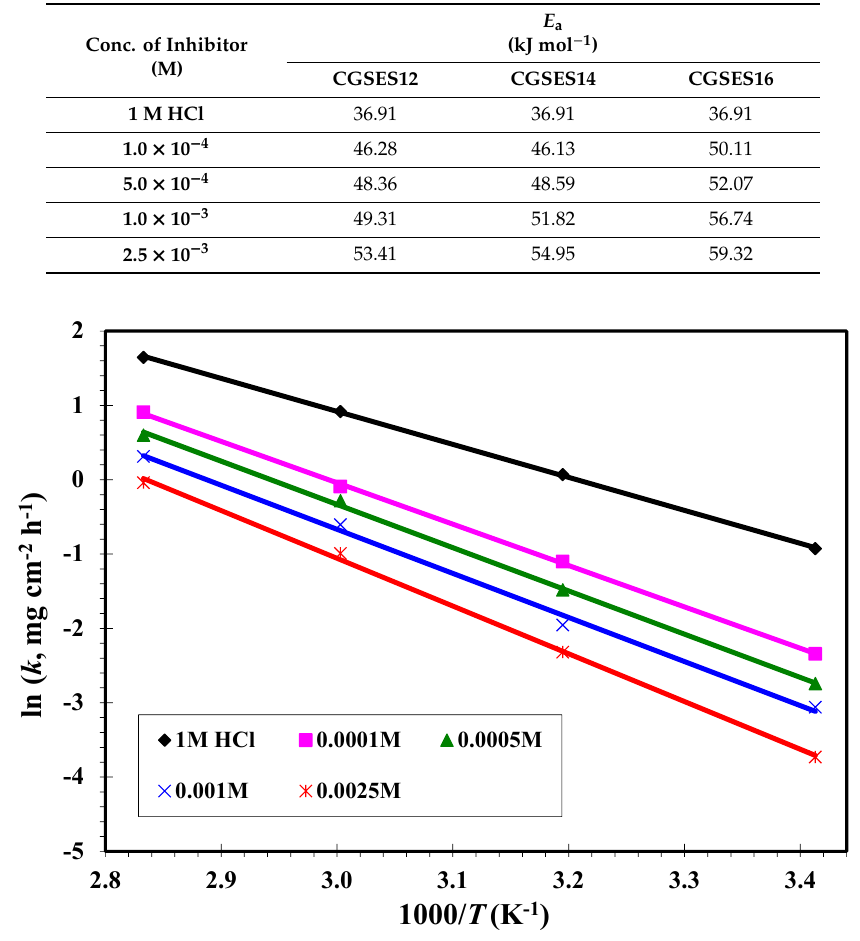
Figure 20. ln k versus 1 / T curves for MS dissolution in the absence and presence of di ff erent concentrations of CGSES12 in 1 M HCl solution.